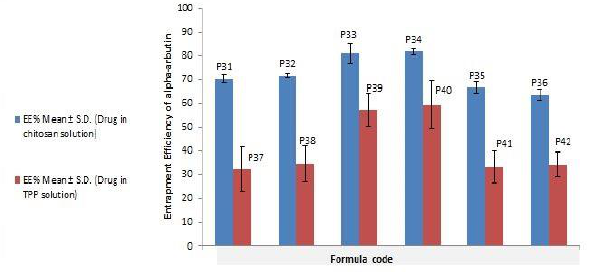
Fig. 4: Effect of mode of drug incorporation in chitosan or TPP solutions on the EE% of loaded